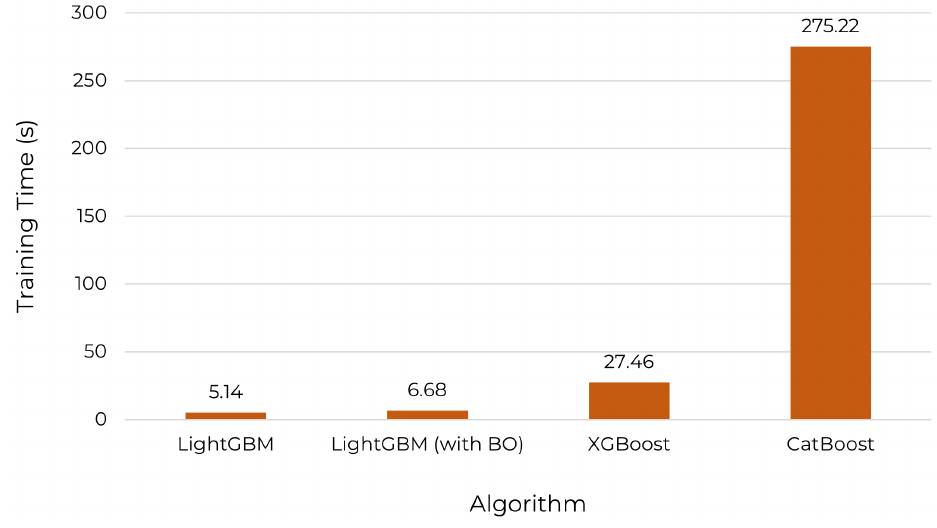
Figure 11. Algorithm training time.